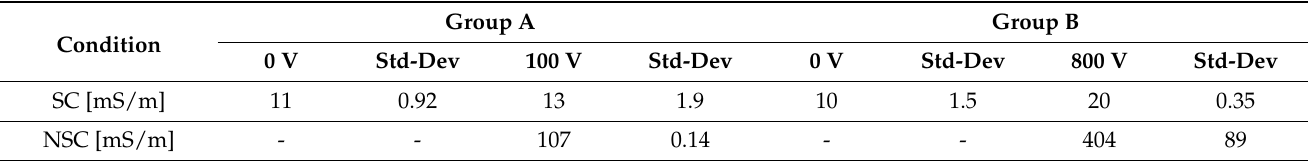
Table 1. Conductivity [mS/m] measurements using the cubic